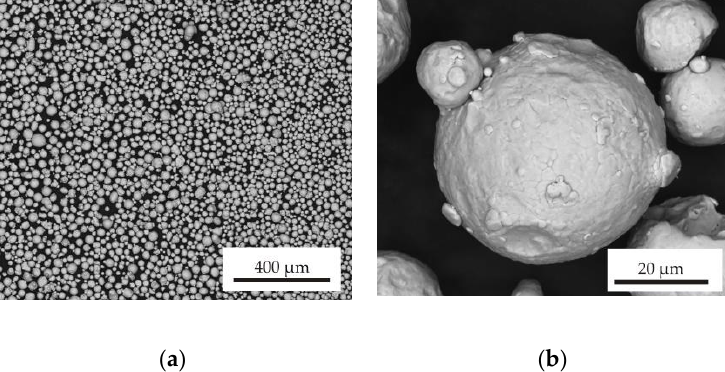
Figure 5. Scanning electron microscopy (SEM) in back-scattered electron (BSE) mode micrographs of atomized powder: ( a ) 200 × magnification ( b ) 5000 ×